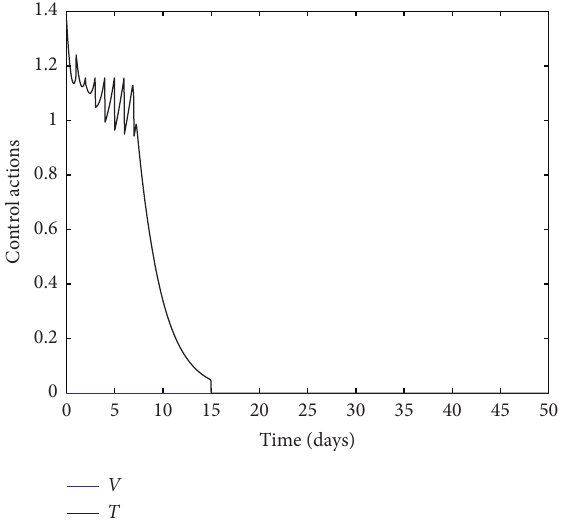
Figure 8: Fully constrained vaccination and treatment efforts and n � 15 days.